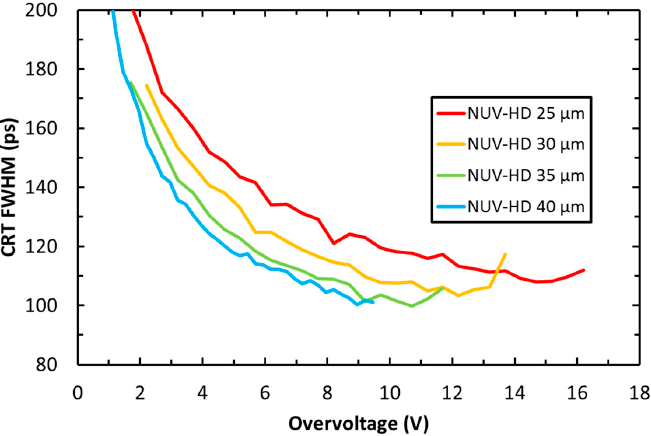
Figure 11. Coincidence reducing time (CRT) as a function of the OV, measured on different cell sizes of the NUV-HD technology.